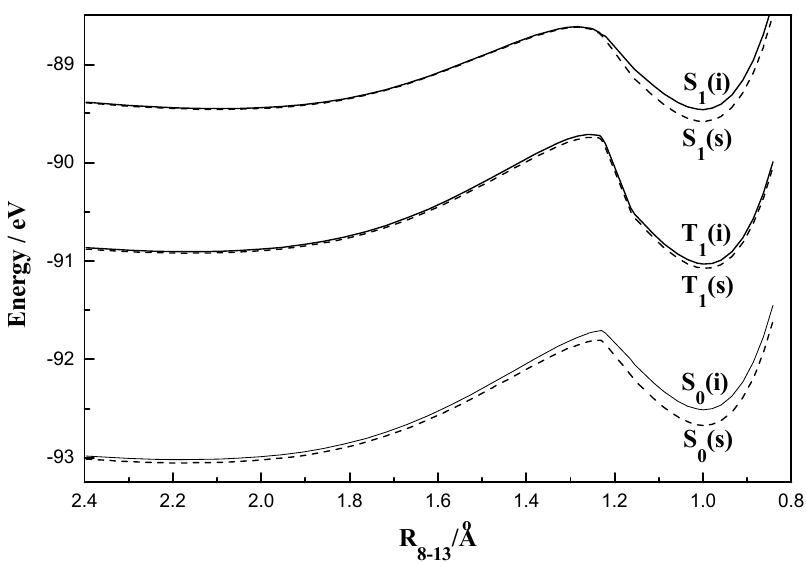
Figure 10. Simulated PECs for IPT process of HPO in S